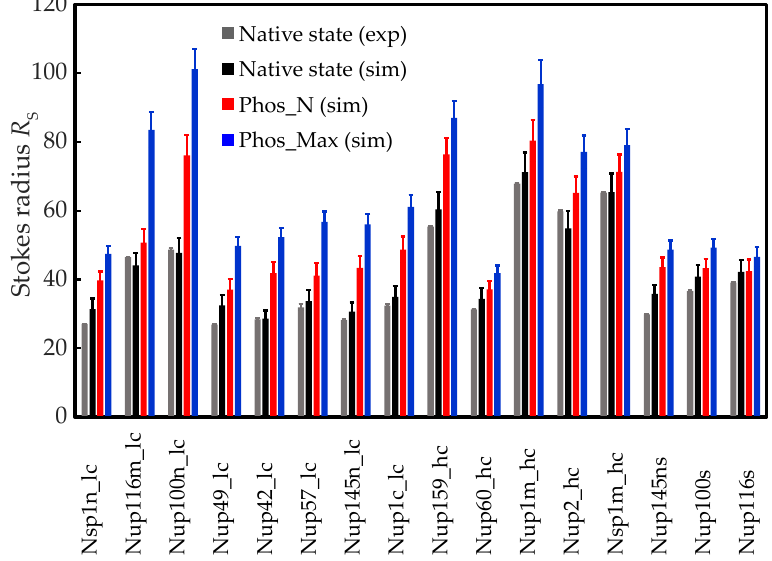
Figure 1. Phosphorylation-induced extension of FG-Nup segments. The Stokes radius R is depicted for a range of FG-Nup segments in their native and phosphorylated states. The suffix lc denotes low charge, hc high charge and s refers to the stalk region of the Nup. The grey and black bars represent the data in the native state from experiments [39] and simulations (results reproduced from [35]), respectively, and the prediction for the phosphorylated states are plotted in red for Phos_N and blue for Phos_Max. For the simulation data, the error bars represent the standard deviation in time (see Table S1 for the source